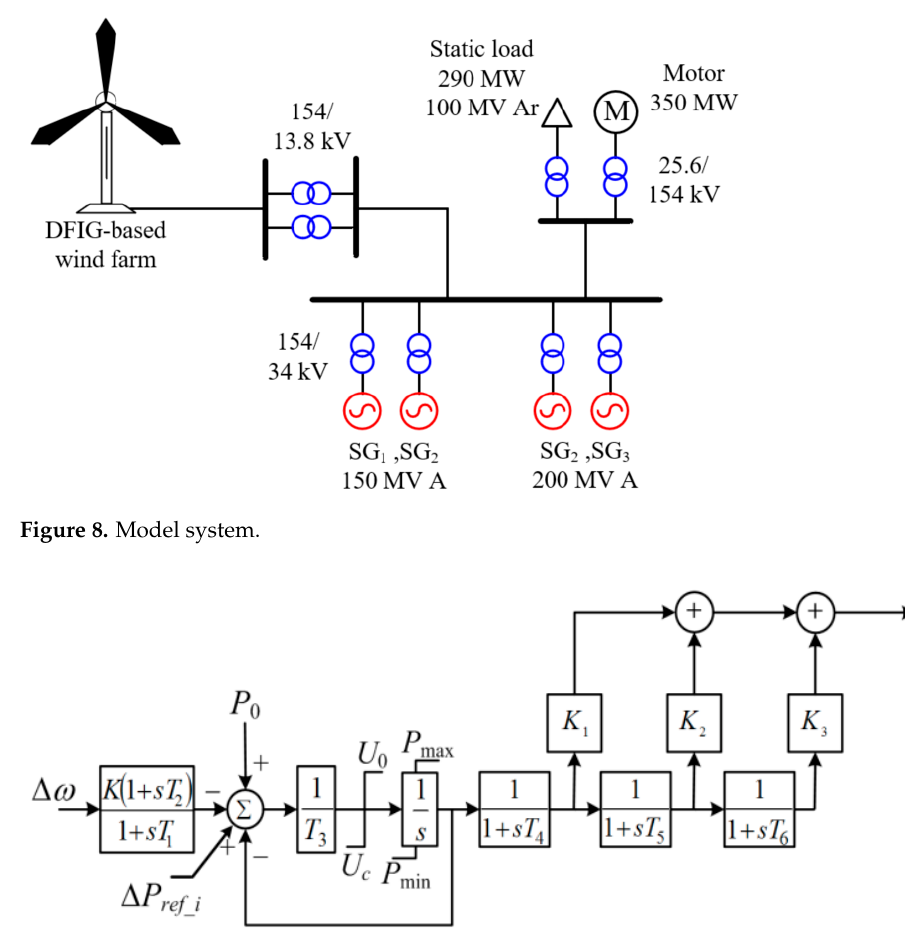
Figure 9. IEEEG1 steam governor model.